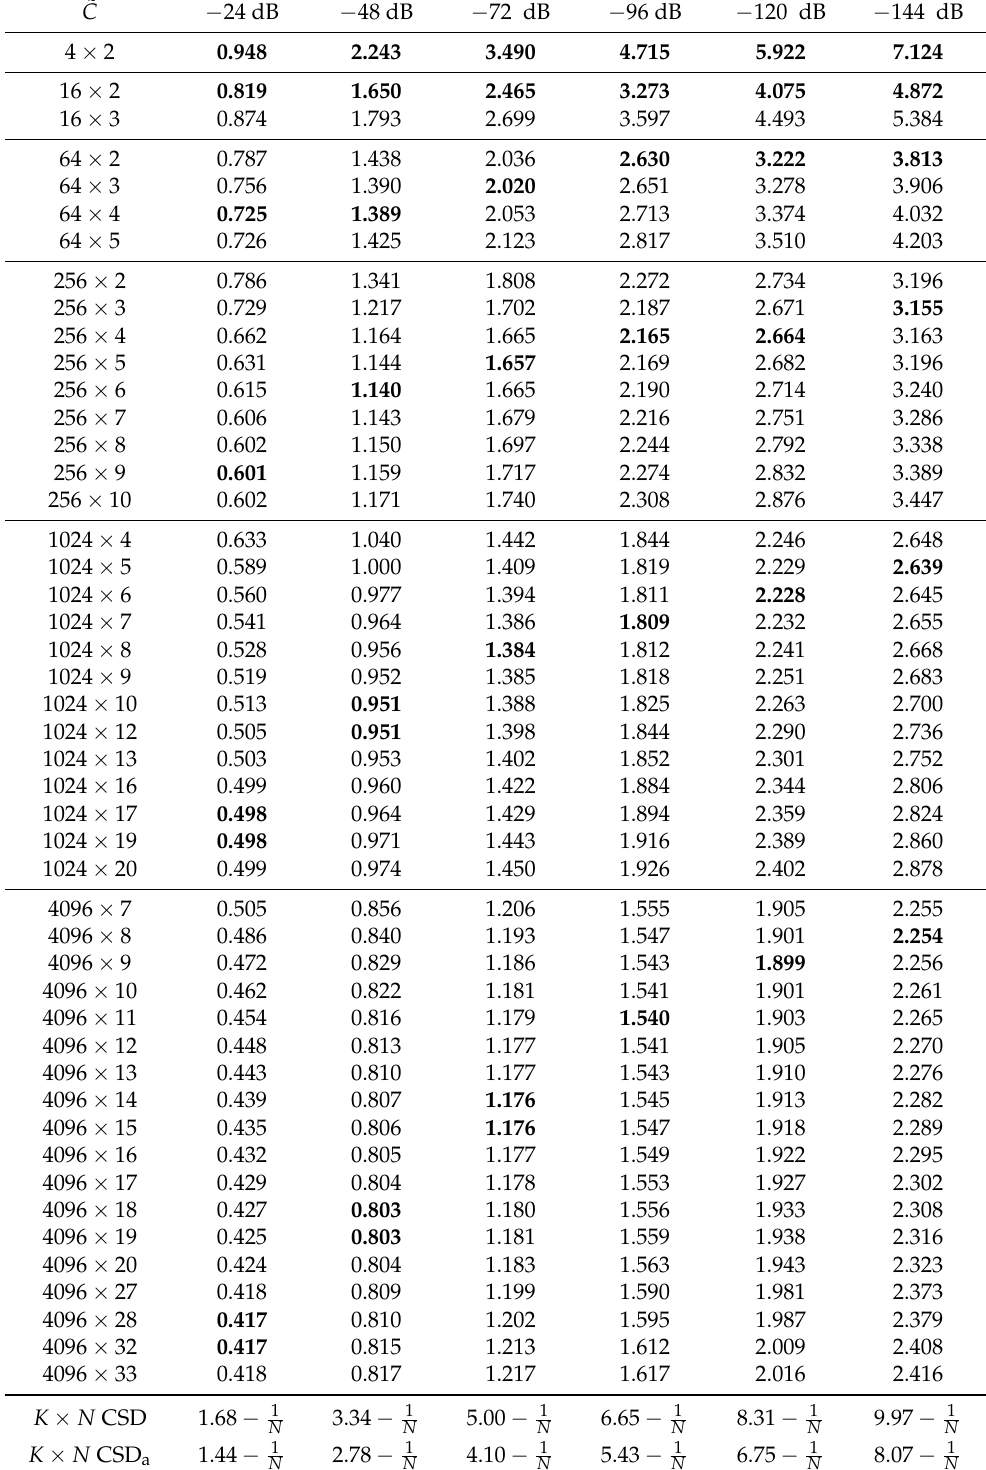
Table 1. Average number of additions per matrix entry that are required to have the median distortion a certain level (between 24 and 144 dB) below the norm of the output vector. Best values for given matrix width are shown in